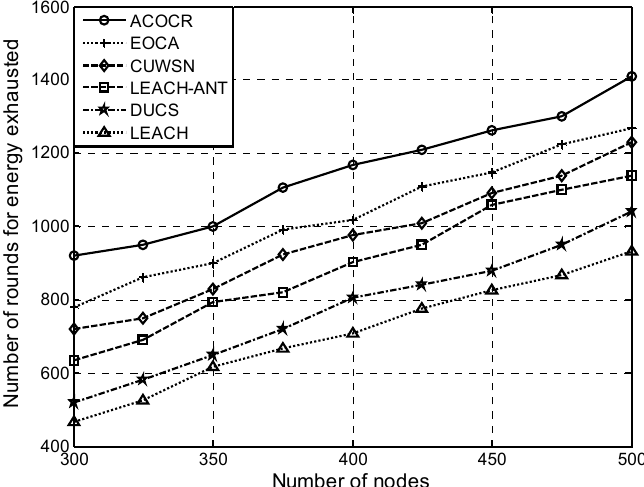
Figure 7. The number of rounds when energy is exhausted versus the number of nodes for the six algorithms.